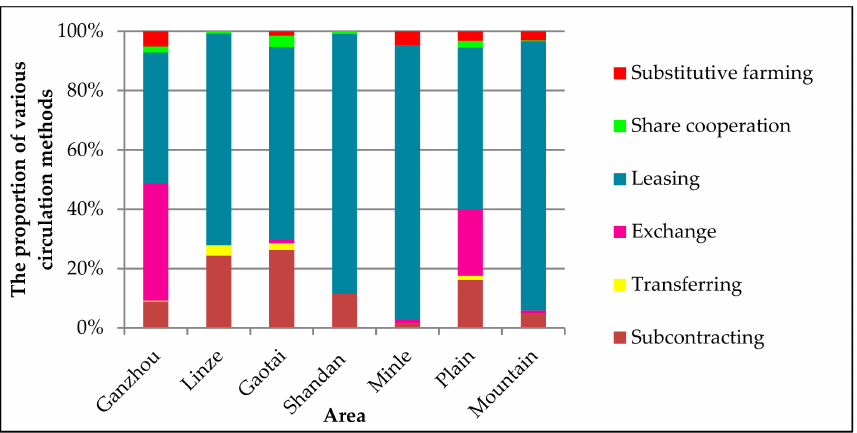
Figure 3. Proportion of farmland circulation modes in various districts of Zhangye